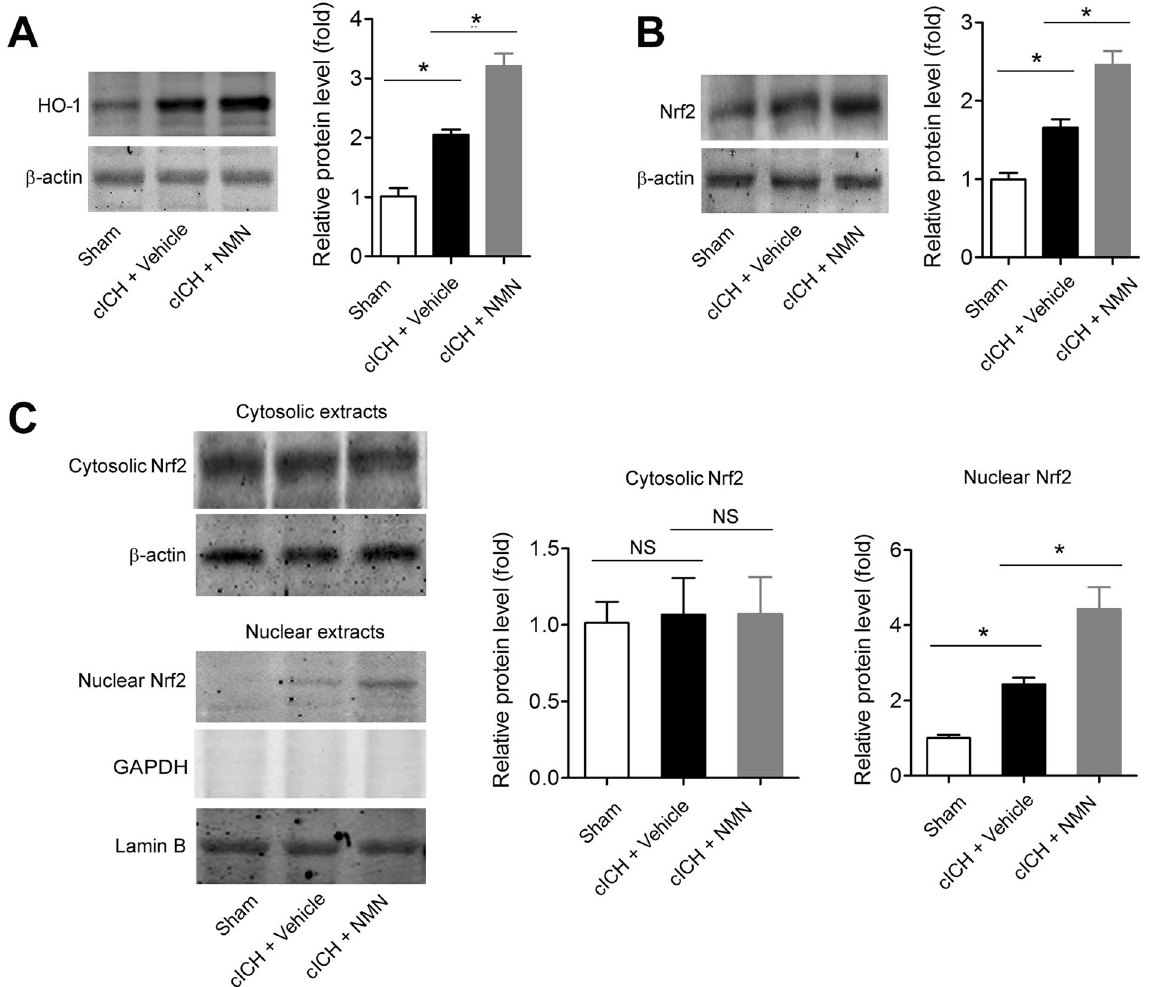
Figure 6. Involvement of Nrf2/HO-1 signaling pathway in therapeutic effects of NMN. ( A ) Representative images and quantitative analysis of HO-1 protein in peri-hemorrhagic brain tissues at 24 hours after cICH. ( B ) Representative images and quantitative analysis of Nrf2 protein in peri-hemorrhagic brain tissues at 24 hours after cICH. ( C ) Representative images and quantitative analysis of Nrf2 protein distribution in cytosolic and nuclear extracts of brain peri-hemorrhagic tissues at 24 hours after cICH. * P < 0.01, n = 5 per group. NS, no